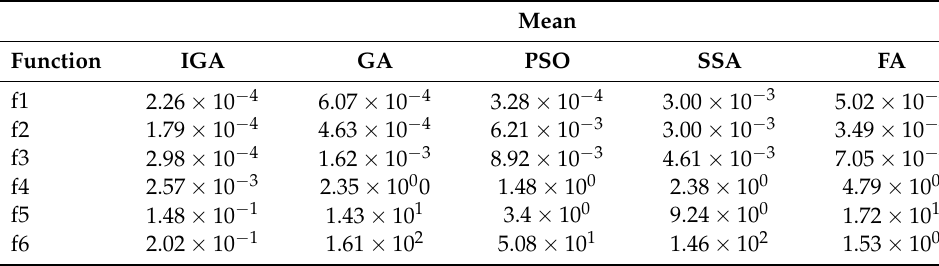
Table 3. Worst value different of test functions about six